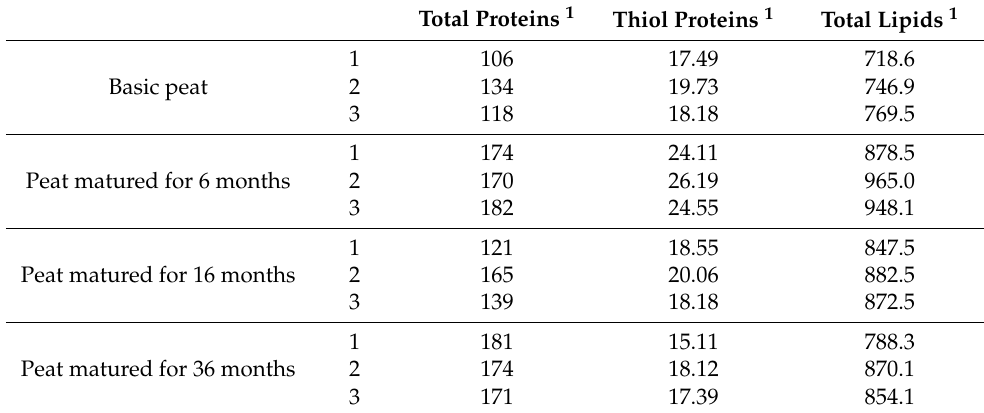
Table 2. Maturation period of peat and total protein, thiol protein, and lipid content.